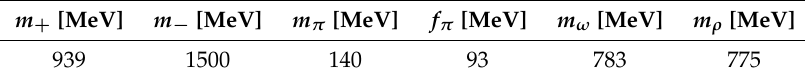
Table 2. Physical vacuum inputs used in this